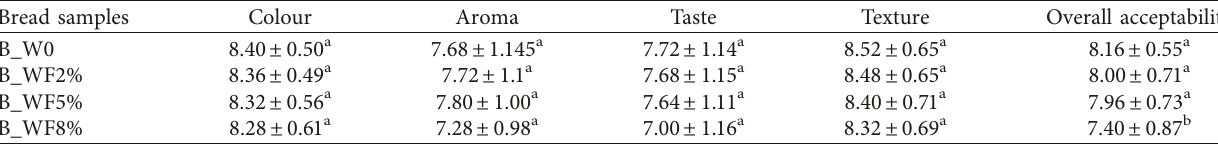
Table 4: Sensory evaluation of different bread